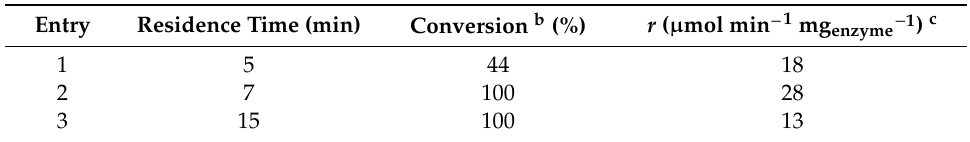
Table 1. E ff ect of the residence time on the flow synthesis of amide N -(2-(diethylamino)ethyl)-4- nitrobenzamide ( 8 ) catalyzed by immobilised MsAcT a